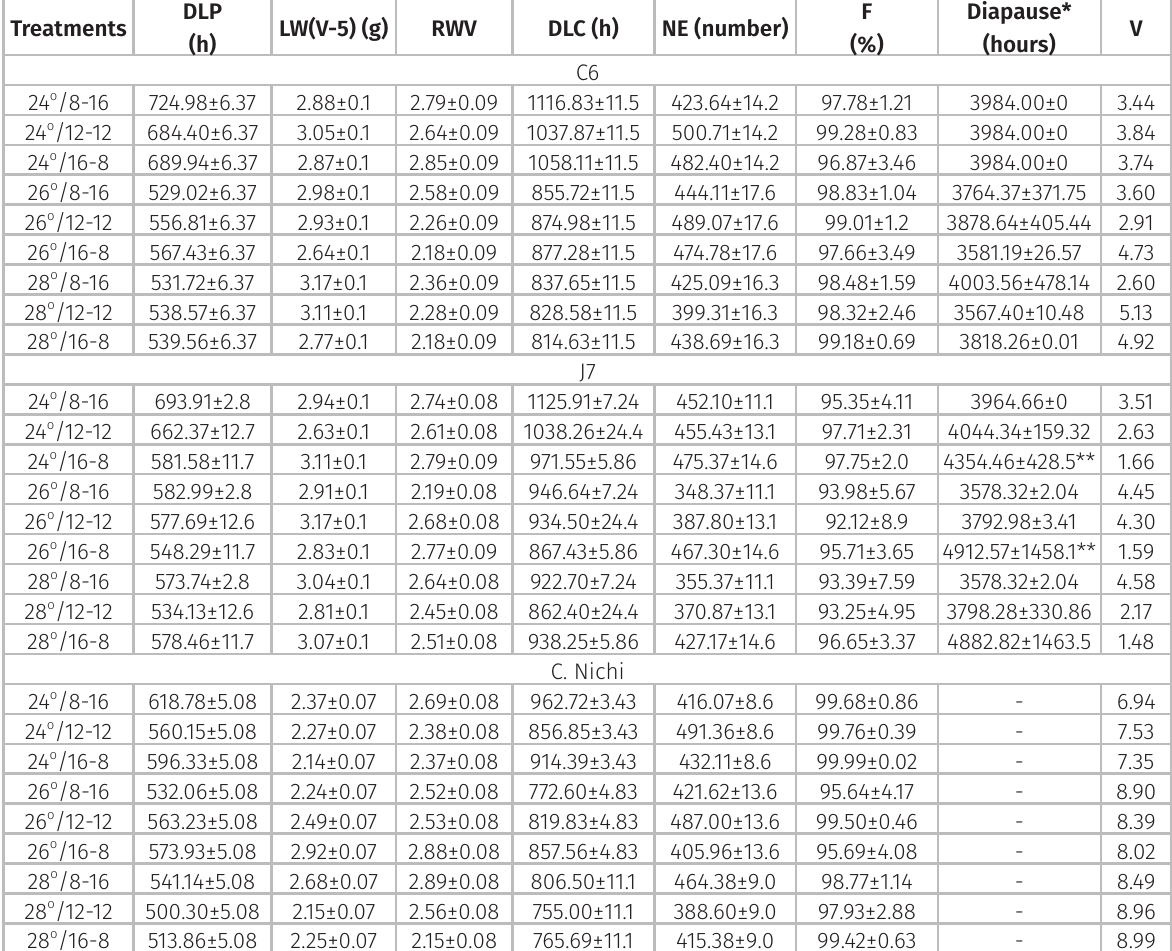
Table II. Mean (± standard error) of the biological characters associated with voltinism and estimated value of voltinism for the nine treatments (temperature*photoperiod) of lines C6, J7 and C. Nichi. DLP: duration of the larval period, DLC: duration of the life cycle, LW(V-5): larval weight of the fifth day of the fifth instar, RWV: rate of weight gain of the fifth instar, NE: number of eggs, F: fertility, V: voltinism.